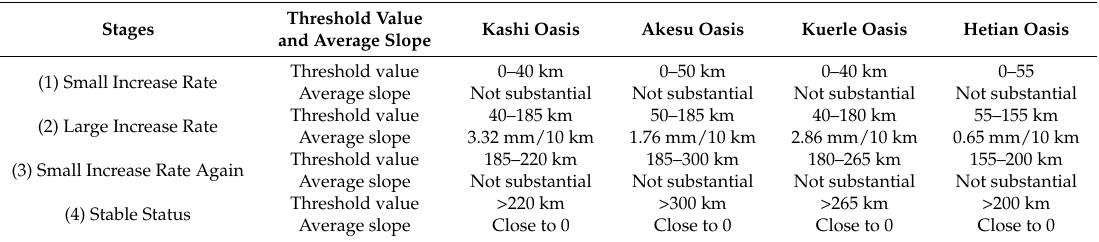
Table 3. Typical patterns of precipitation evolution with the increase of oasis width in different oases of the Tarim Basin based on the simulated